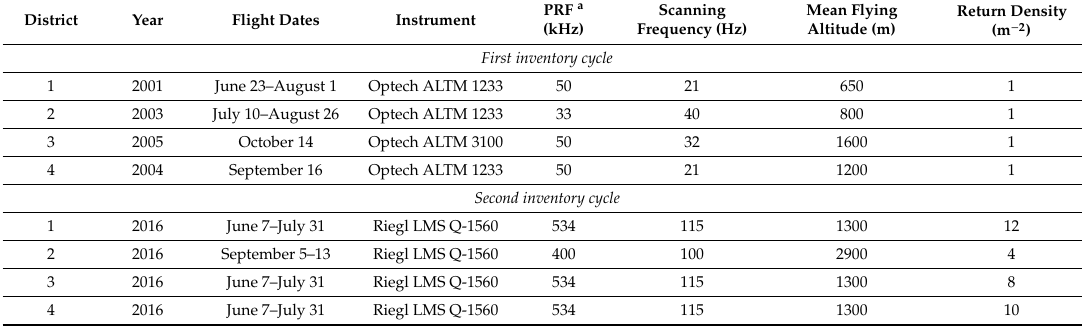
Table 3. Airborne laser scanning acquisition